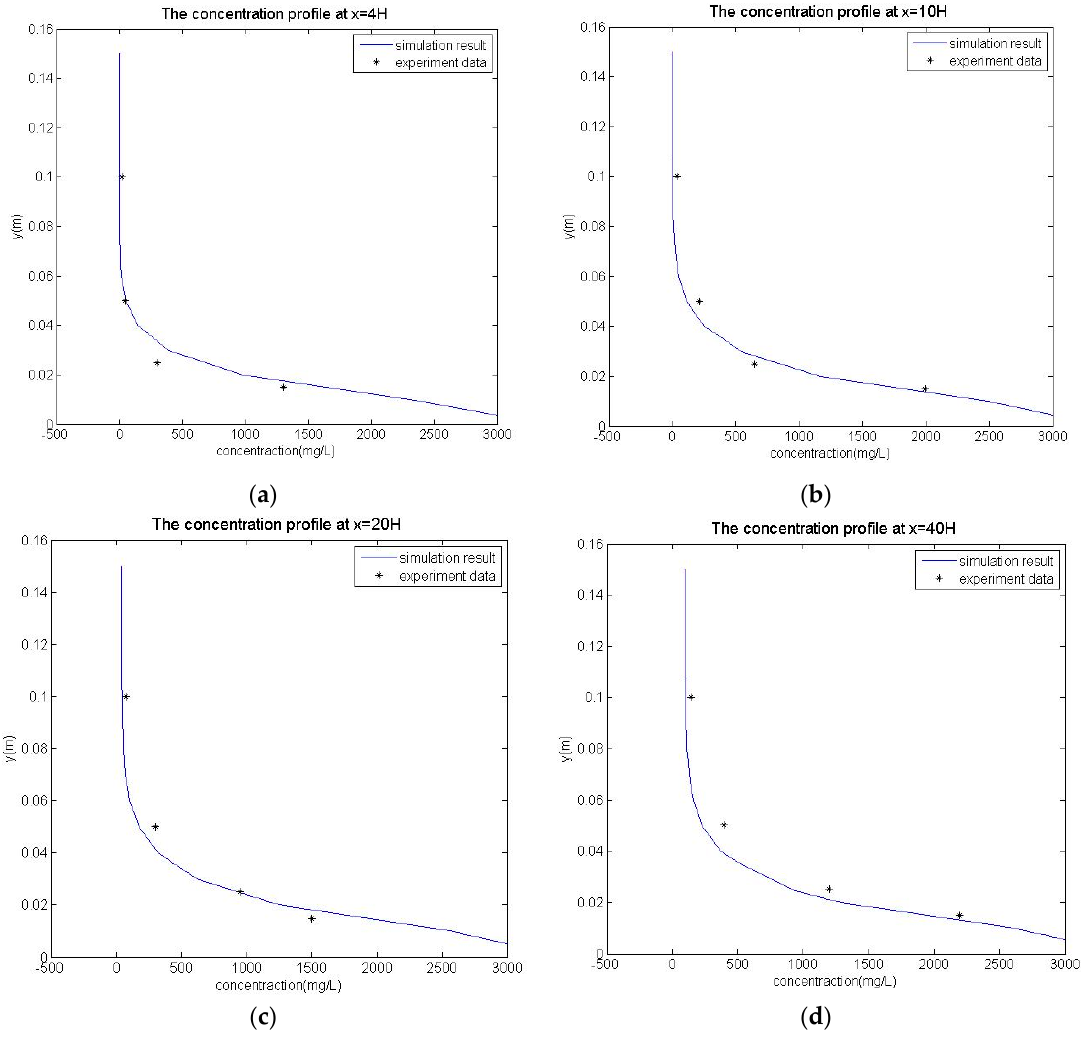
Figure 7. Sediment concentration profile in specified sections ( a ) x = 4 H ; ( b ) x = 10 H ; ( c ) x = 20 H ; ( d ) x = 40 H .